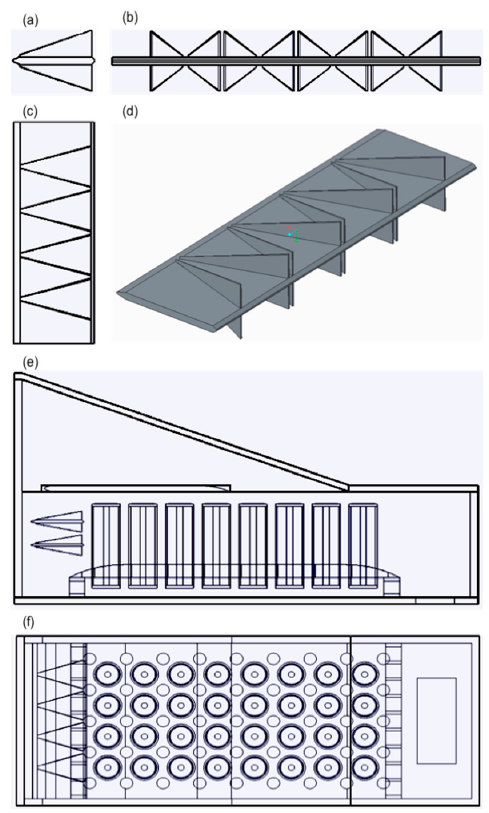
Table 2. Summary of all the battery pack configurations.